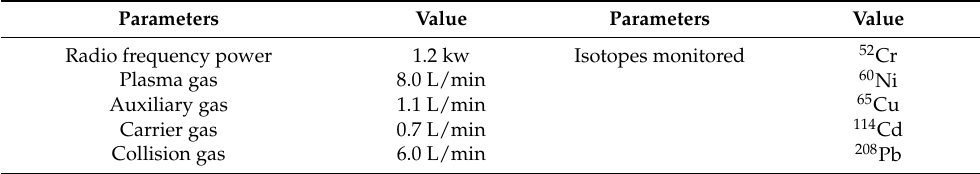
Table 2. Optimized operating for ICP-MS.